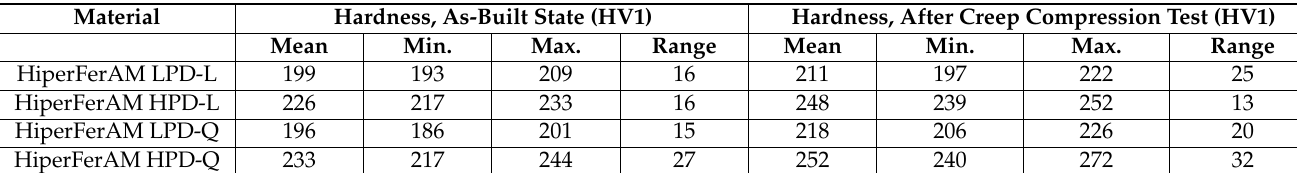
Figure 12. HiperFer AM ( a ) LPD and ( b ) HPD EBSD mappings taken perpendicularly to the fracture surfaces after the tensile experiments at ambient temperature. Table 4. Hardnesses of LPD and HPD HiperFer AM in the as-built state and after compression creep